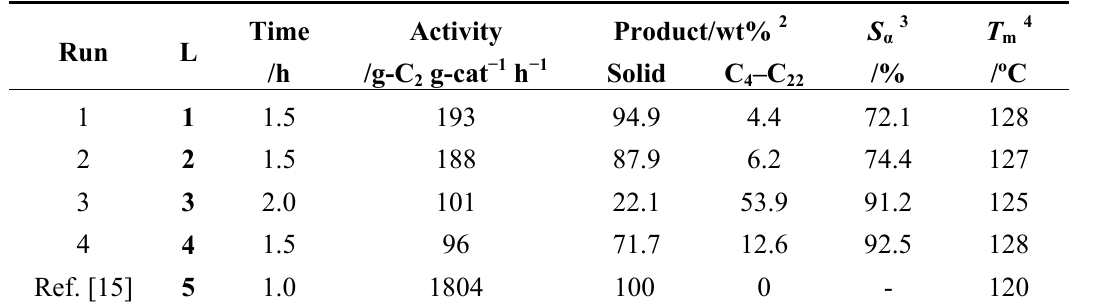
Table 1. Oligomerization of ethylene using heterogeneous α -diiminenickel(II) catalysts 1 . Run